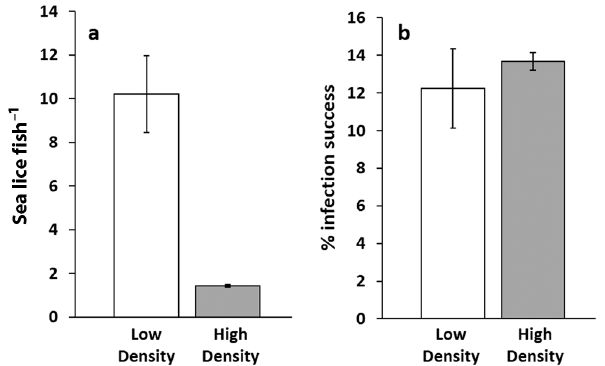
Fig. 2. Mean ± SE (a) sea lice Lepeophtheirus salmonis per salmon Salmo salar and (b) infection success (percent of in- fection intensity) after infection at low (12 fish; 7.9 ± 1.0 kg m −3 , mean ± SE; open bars) and high (96 fish; 68.5 ± 5.8 kg m −3 ; grey bars) fish